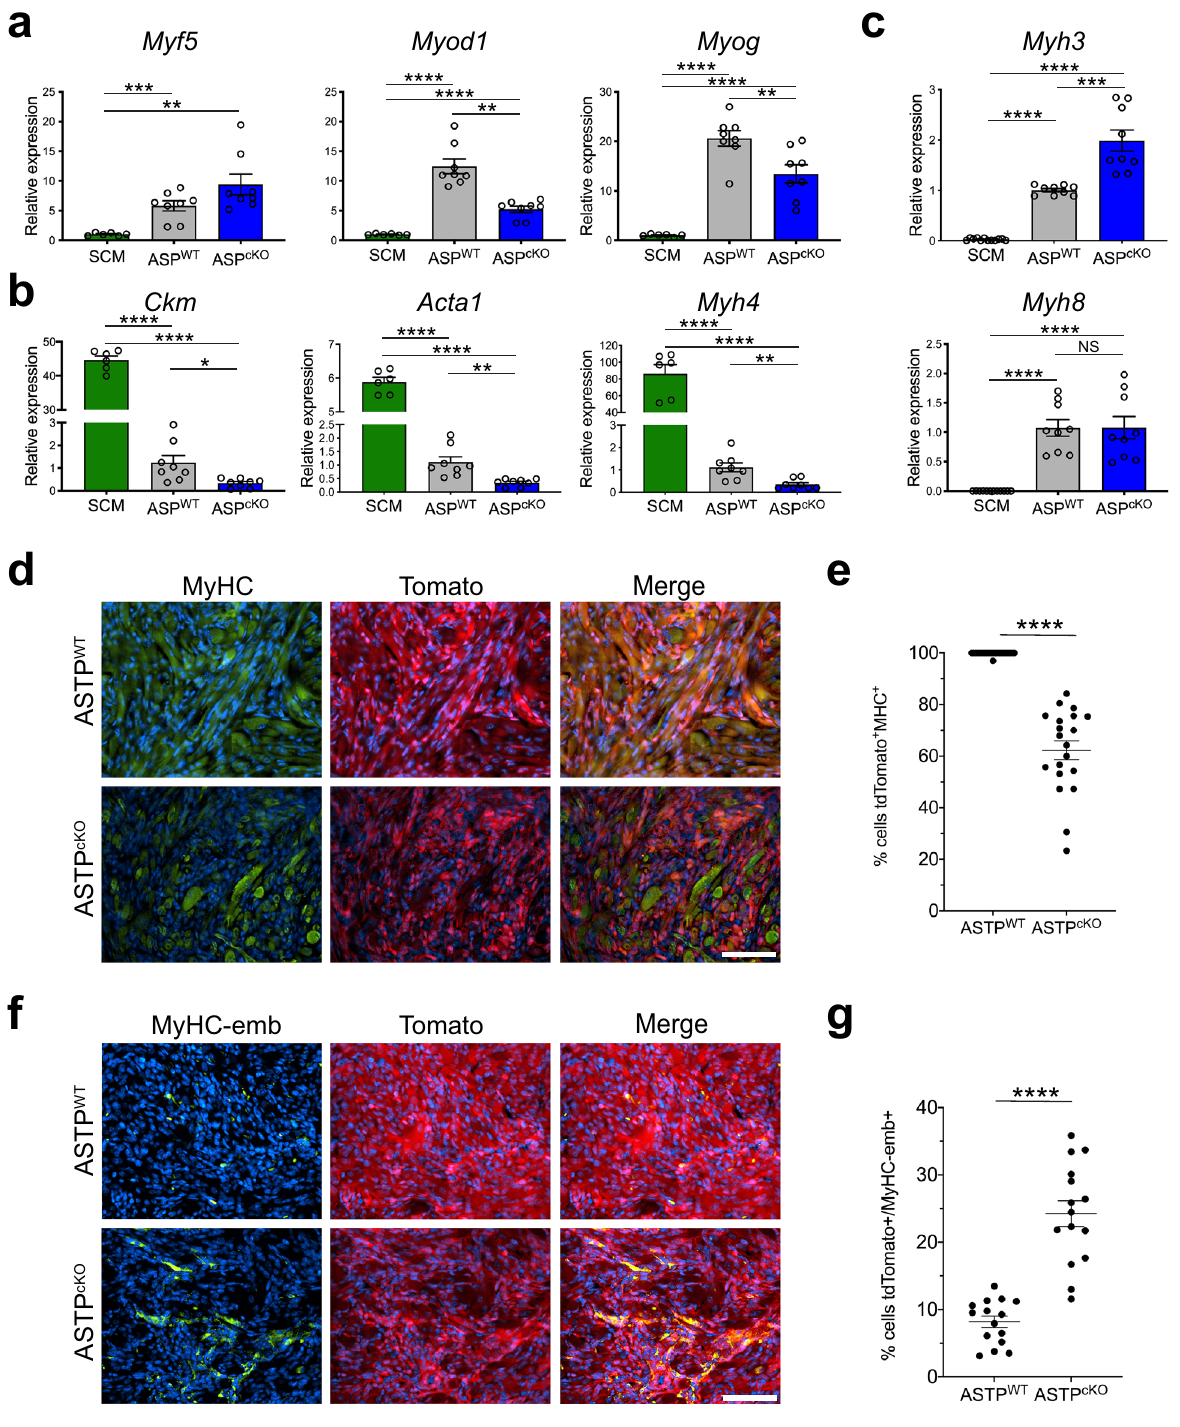
increased in the ASP cKO tumors compared to ASP WT . However, no change in expression with neonatally expressed Myh8 suggests ASP cKO tumors resemble an earlier skeletal muscle progenitor (Fig. 2c). To better de fi ne the tumor cell differentiation state in the ASP cKO and ASP WT tumors, we bred Rosa26 tdTomato reporter mice into the ASP WT and ASP cKO models to generate ASTP mice. In the ASTP mice, tumor cells that have expressed aP2-Cre are indelibly labeled with tdTomato allowing tumor cell visualization. Immuno fl uorescent staining illustrated that nearly all tdTomato + tumor cells in ASTP WT mice expressed